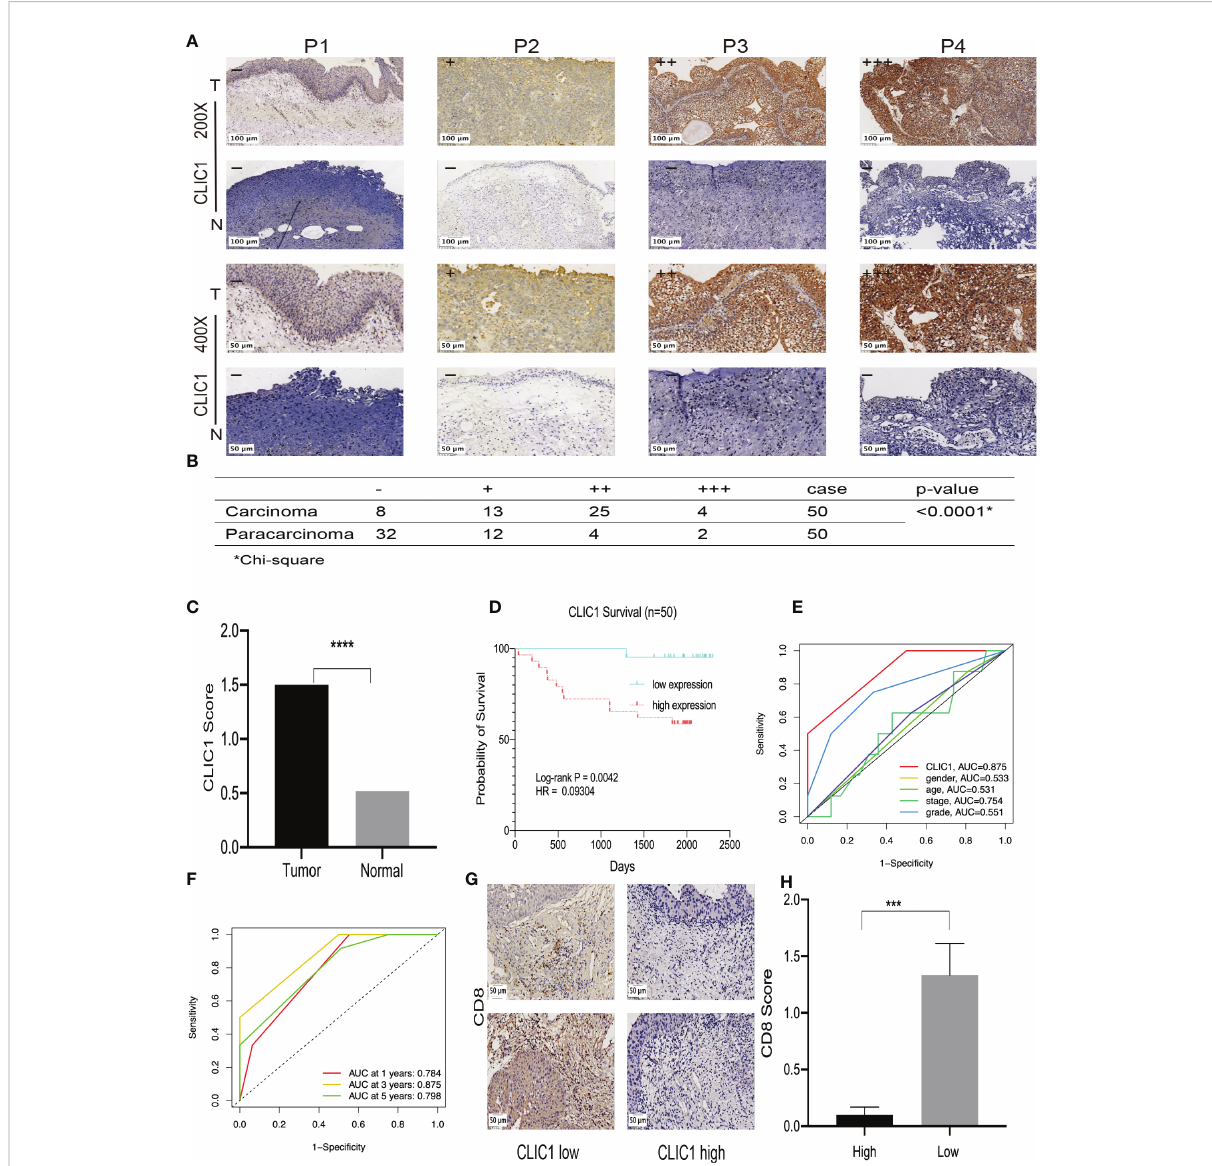
FIGURE 7 Immunohistochemistry of CLIC1 and CD8 expression and the Kaplan-Meier survival and ROC analysis of CLIC1 index in predicting the prognosis of BC. (A) Representative images of negative ( − ), weakly positive (+), moderately positive (++), and strongly positive (+++) CLIC1 staining by IHC analysis. (B) Statistical analysis of differing degrees of CLIC1 staining in bladder cancer tissues. (C) Expression levels (IHC score) of CLIC1 in bladder cancer tissues and paired adjacent paracarcinoma tissues. (D) Kaplan-Meier survival analysis based on CLIC1 expression levels. (E) Time ROC curves at 3 years of overall survival based on the CLIC1, age, gender, stage, and grade. (F) Time ROC curves at 1, 3, and 5 years of overall survival based on the CLIC1. (G, H) Immunohistochemistry for CD8. (*Chi-square, ***p ≤ 0.001, **** p ≤